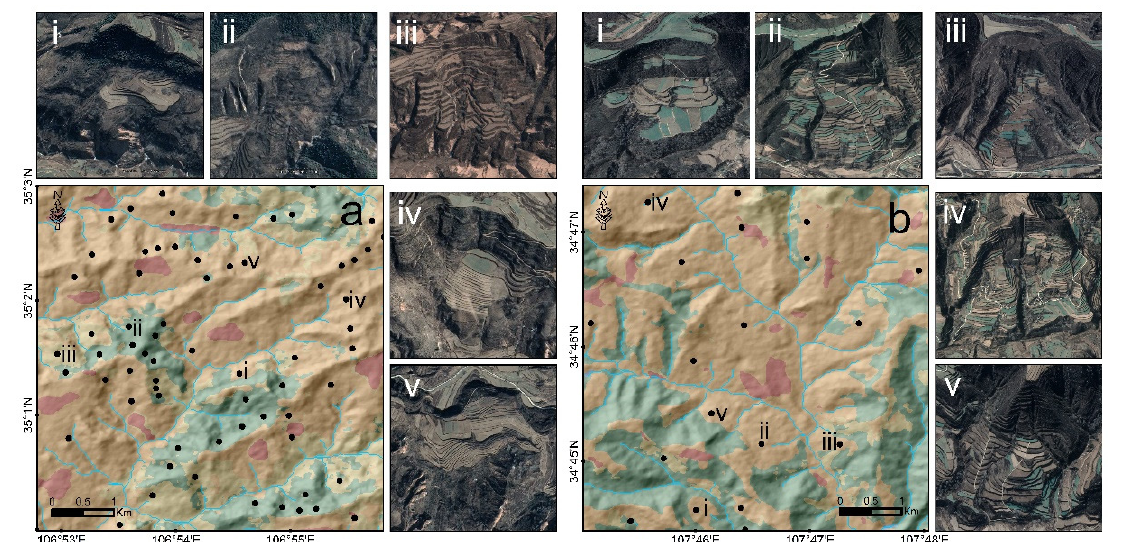
Figure 15. Typical ‘landslide aggregation zone’ in the study area. The black point represents a single landslide, and the surrounding remote sensing images are five typical landslides. The locations of ( a , b ) are shown in Figure 12.